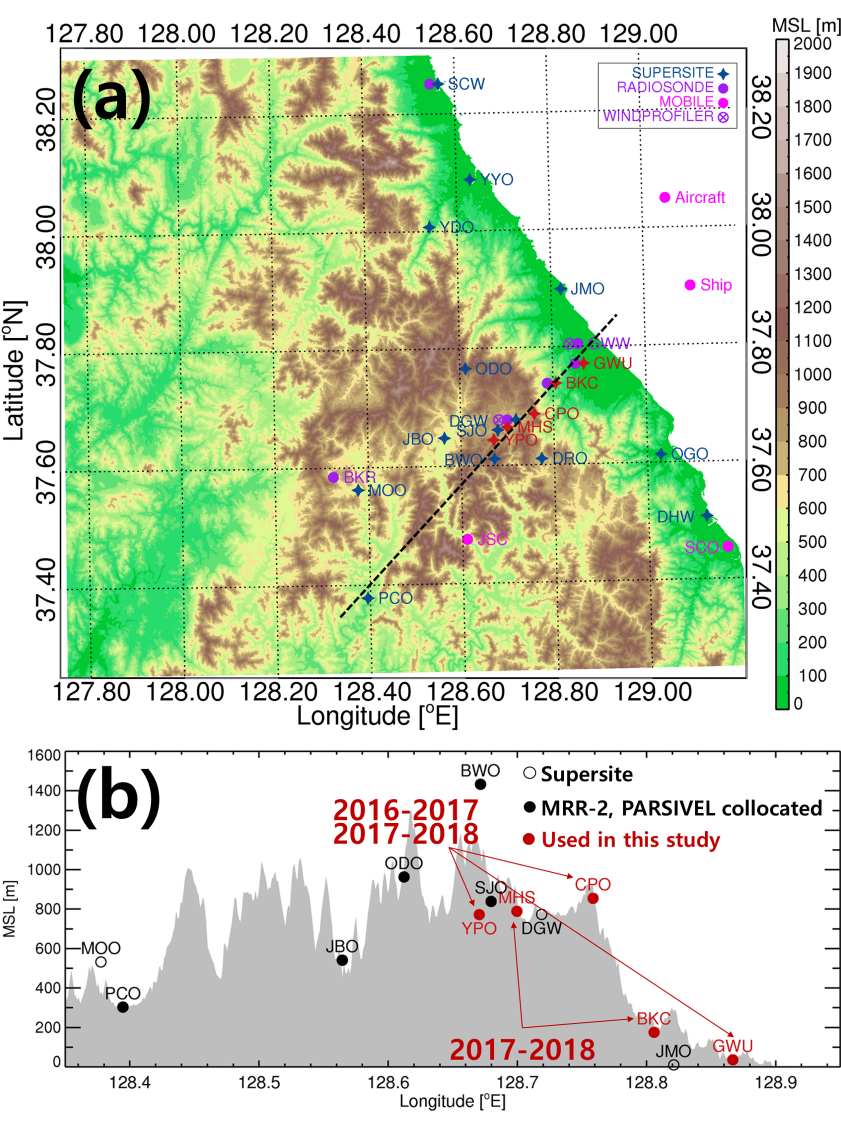
Figure 1. (a) Locations of supersites and sounding sites of ICE-POP 2018 and (b) the vertical cross-section along the thick dashed line in (a) . Terrain height is filled in gray in (b) . The five sites used in this study are colored red. The period of MRR and PARSIVEL measurements is noted with